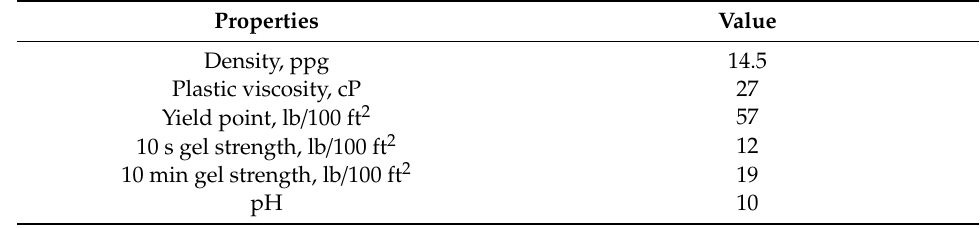
Table 2. Drilling fluid rheological properties at room